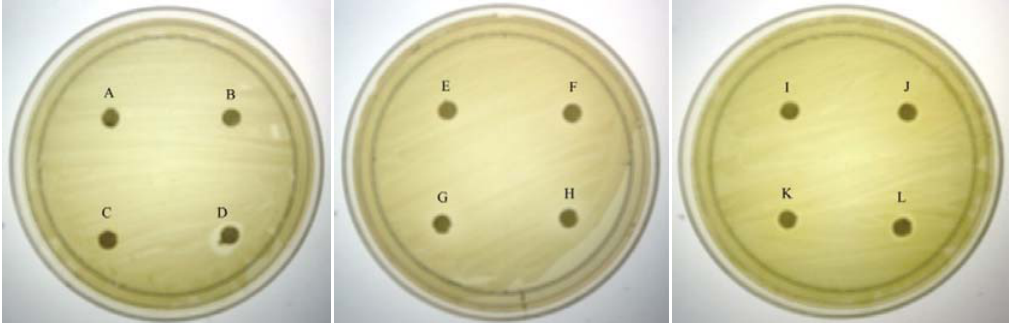
Figure 1. Antibacterial assay. ( A ) Disc without treatment; ( B ) 20% DMSO; ( C )